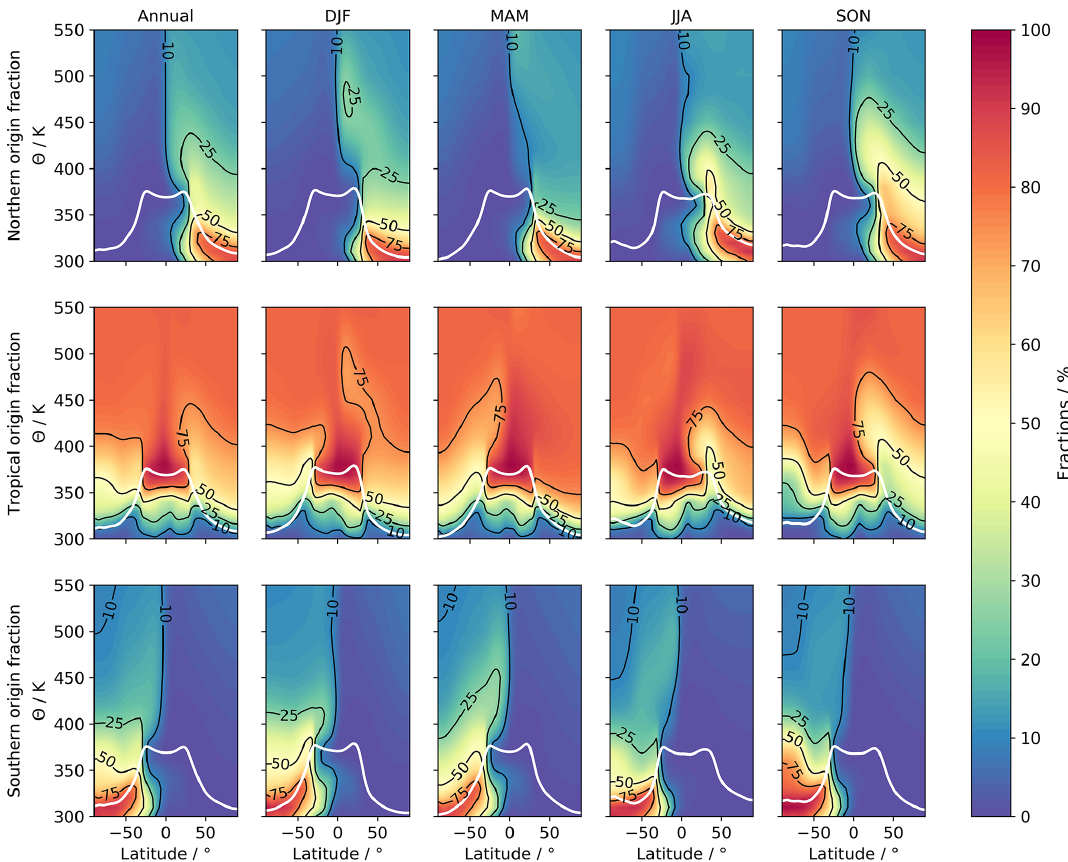
Figure 2. CLaMS origin fractions from TpSim as annual (left column) and seasonal (remaining four columns) mean global cross sections from the northern hemispheric (top row), the tropical (middle row), and the southern hemispheric (bottom row) tropopause source region (for definition see text). The solid white line indicates the WMO tropopause from ERA-Interim output. Negative latitudes always denote the Southern